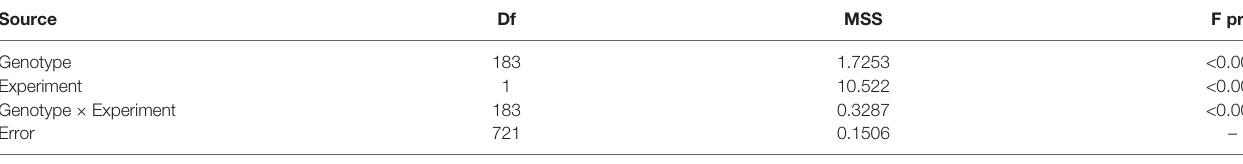
TABLE 1 | Analysis of variance for tan spot in the GWAS panel and distribution of tan spot score in checks and 184 wheat genotypes. Source Df